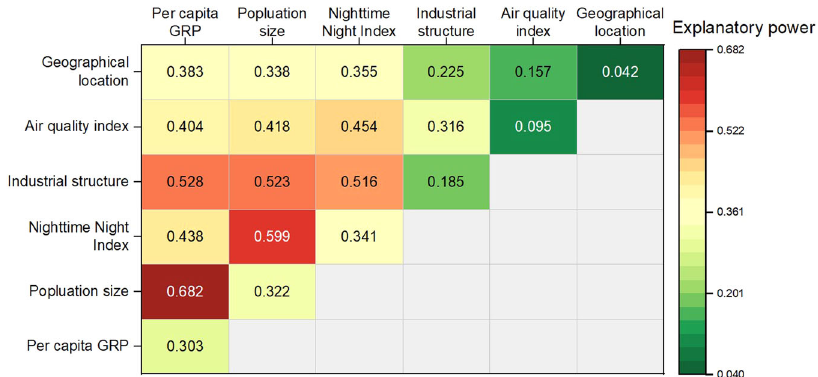
Fig. 5 Explanation strength for the actual attributes on the development level of pseudo-human settlements (PHS). The value of the diagonal cell is the result of the factor detector of the reality attribute, indicating to what extent the attribute explains the spatial differentiation of the pseudo-human settlements index (PHSI). Other cells report the result of the interaction detector, representing the explanatory power of the spatial differentiation of PHSI when the reality attributes of the row and column act together. The fi gure was developed by the authors using Origin Pro Version 2021.